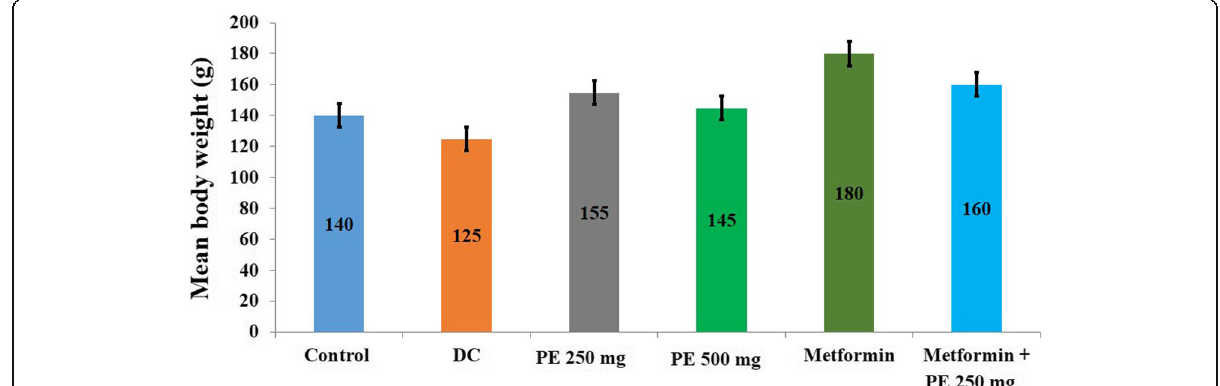
Fig. 2 Effect of the oral administration of N. cadamba flower extract on the mean body weight in normal and diabetic rat. Effect of the oral administration of N. cadamba flower extract (given separately at two different doses or in combination with the standard metformin) on the mean body weight in normal and diabetic rat. Here, DC = Diabetic control, PE = Plant extract. All the values are expressed as mean ± SEM, sample size (n = 5), (*) indicates p < 0.05 compared to diabetic control group, (+) indicates p < 0.05 compared to normal